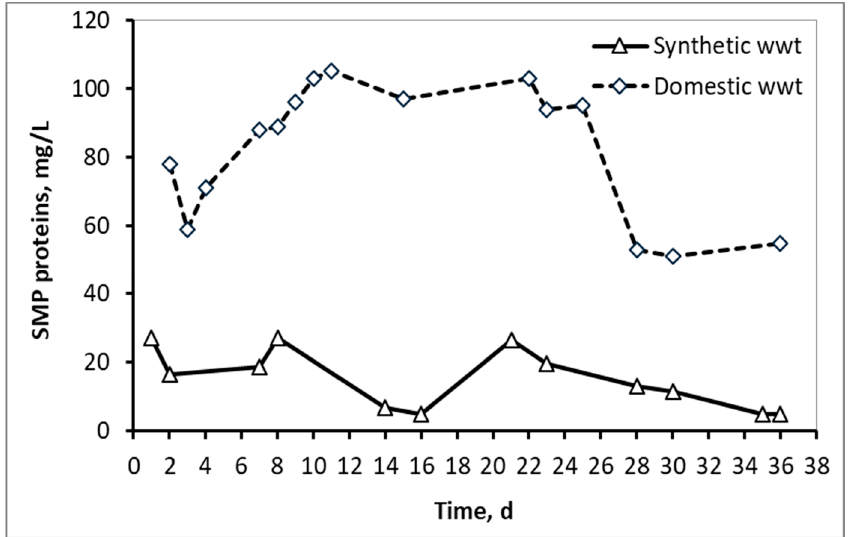
Figure 3. SMP concentration in the form of proteins in the mixed liquor of synthetic and domestic wastewater.